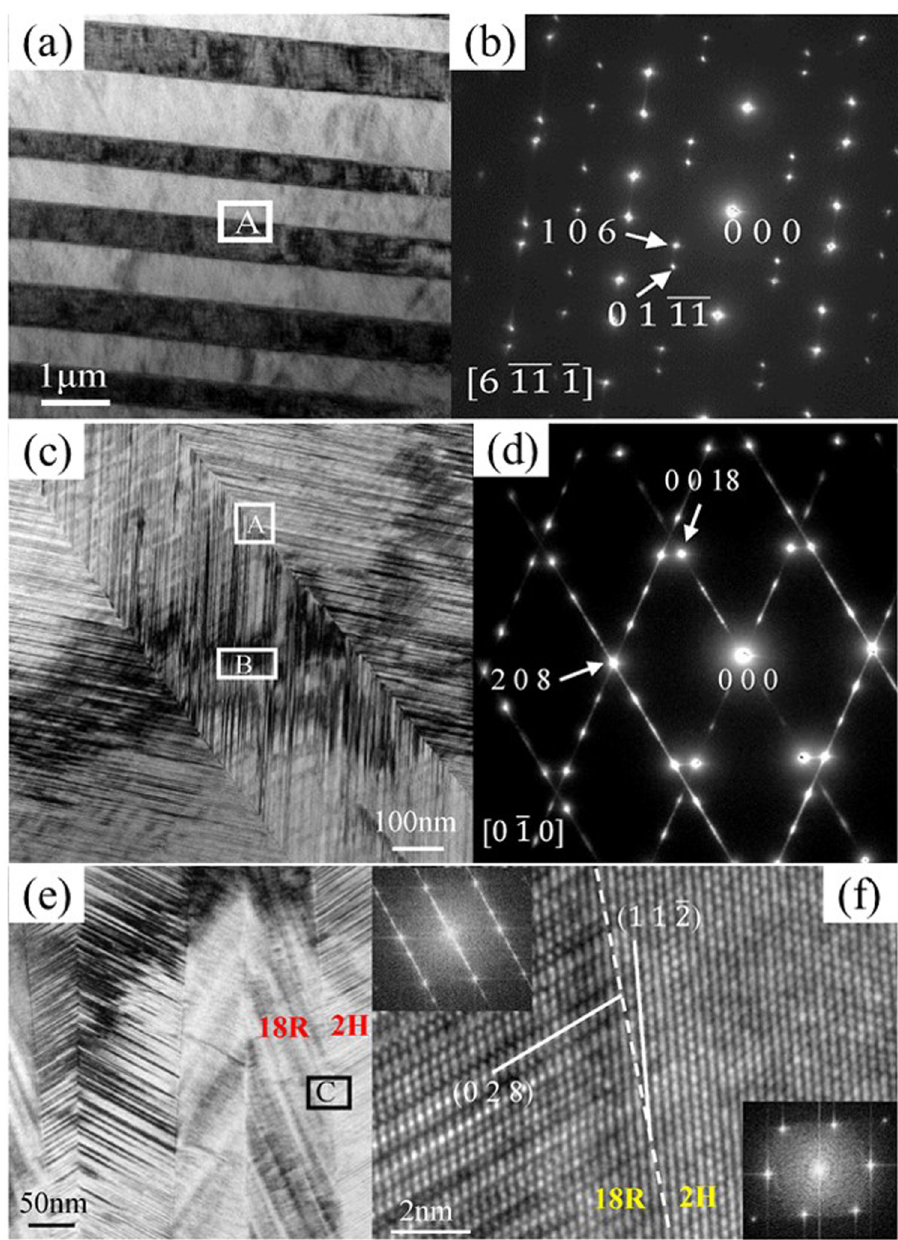
Figure 6: TEM images of Cu – 13.0Al – 4.0Ni – 1Nd alloy: ( a ) bright fi eld image, ( b ) electron di ff raction of region A in ( a ) , ( c ) bright fi eld image, ( d ) electron di ff raction of region A in ( b ) , ( e ) bright fi eld image, and ( f ) electron di ff raction of region C in ( e ) [ 91 ]